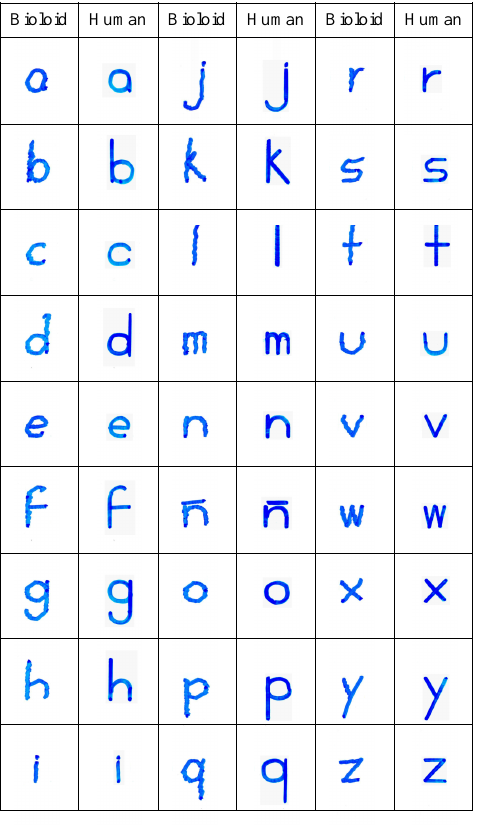
Figure 11. Drawing of the alphabet characters with the Bioloid’s right arm and the kinematics models ( r = 0.5 cm).